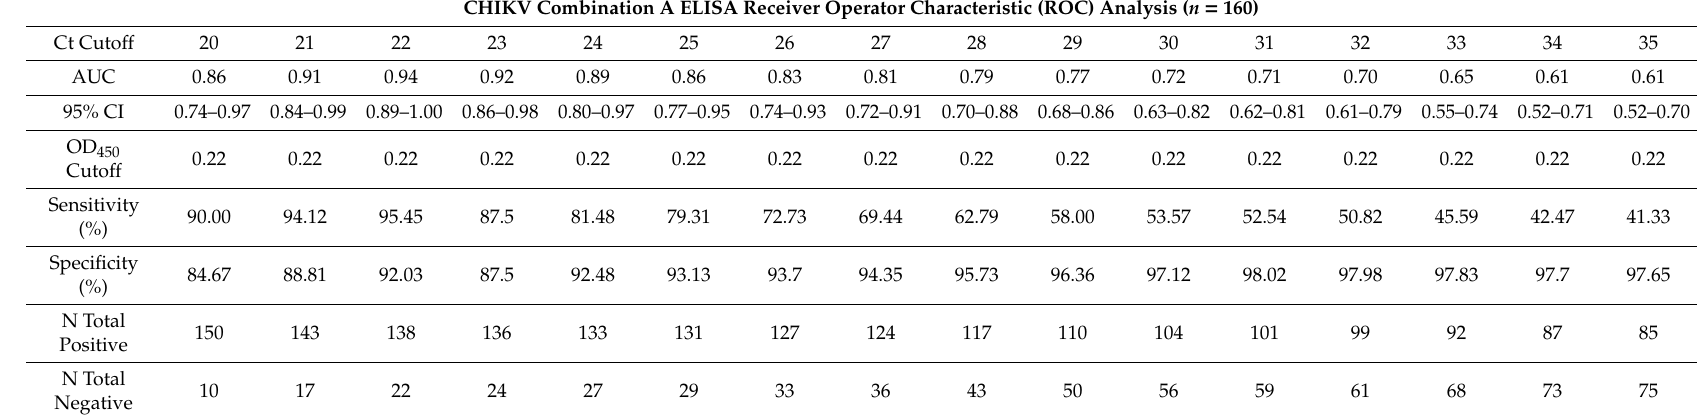
Table 1. Performance of CHIKV E1 / E2 ELISA Test. Area under curve (AUC) of ROC curve, 95% confidence interval (95% CI), optimal OD 450 cuto ff , sensitivity (%), specificity (%), and sample counts were calculated for incremental PCR Ct cuto ff s for the E1 / E2 ELISA test using antibody Combination A (48,